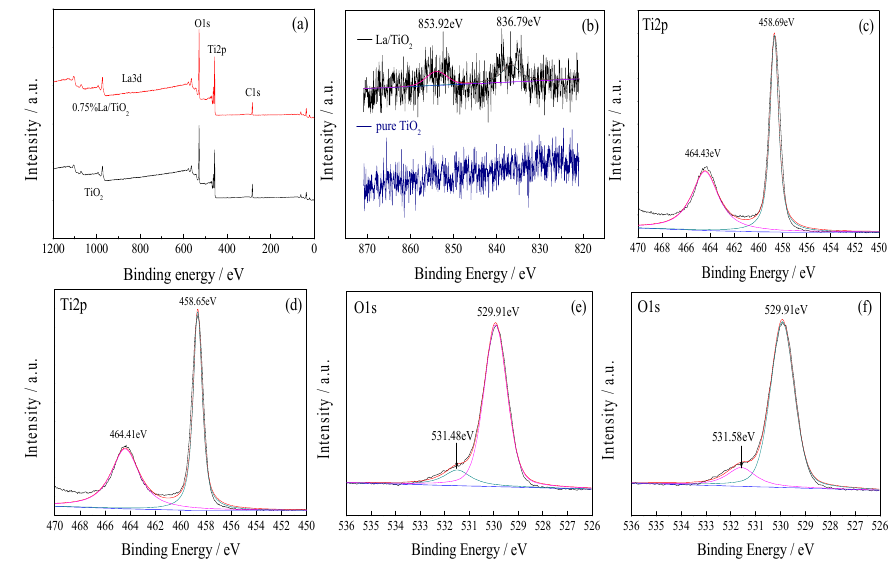
Figure 2. X-ray photoelectron spectroscopy (XPS): ( a ) survey spectra; ( b ) La3d; ( c ) Ti2p of pure TiO 2 ; ( d ) Ti2p of La/TiO 2 ; ( e ) O1s of pure TiO 2 ; ( f ) O1s of La/TiO 2 .